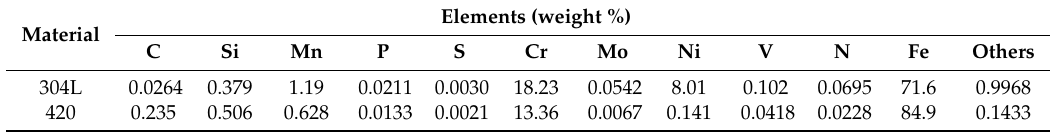
Table 1. Spectral analysis of 304L and 420 stainless steel plates.